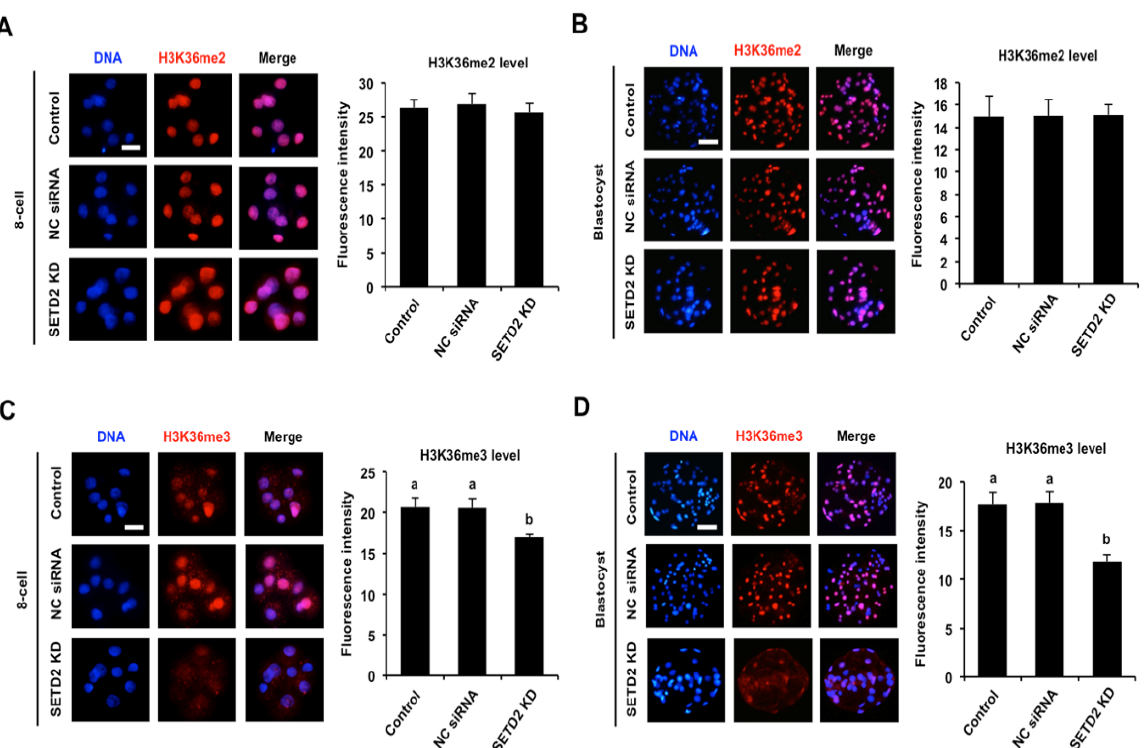
Figure 3. Effects of SETD2 KD on H3K36me2 and H3K36me3 levels. Immunostaining of H3K36me2 or H3K36me3 in eight-cell embryos ( A , C ) and blastocysts ( B , D ). Embryos were stained for H3K36me2 or H3K36me3 (red) and DNA (blue). The independent experiment was carried out for three times and 30 embryos in each group were at least included. Representative images obtained by confocal microscopy are shown. Scale bar: 50 µ m. Quantitative analysis of fluorescence intensity of H3K36me2 and H3K36me3 is provided in the right panel. The experiment was independently repeated three times with at least 30 embryos per group. All data are shown as mean ± S.E.M and different letters on the bars indicate significant differences ( p <